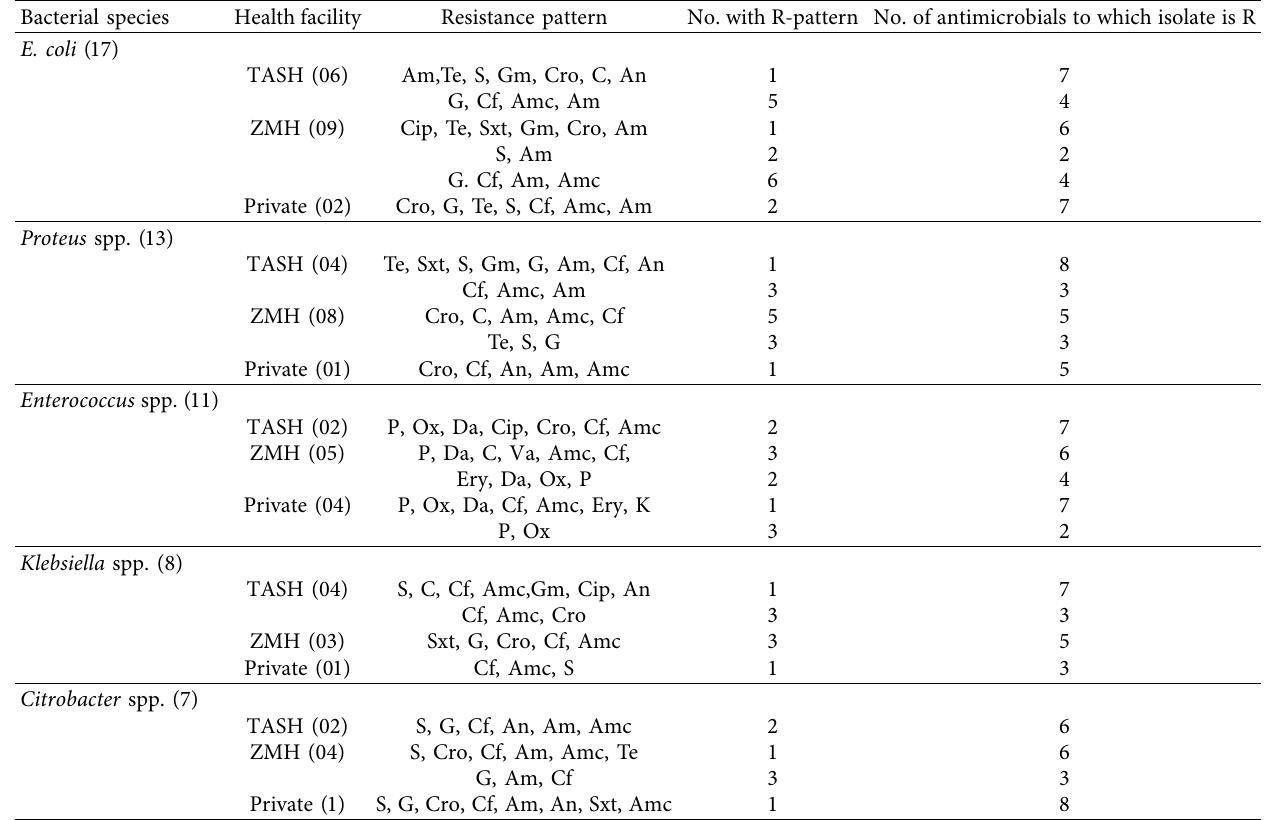
Table 4: Antimicrobial resistance pattern of bacterial pathogens isolated from pregnant women ( N =56). Bacterial